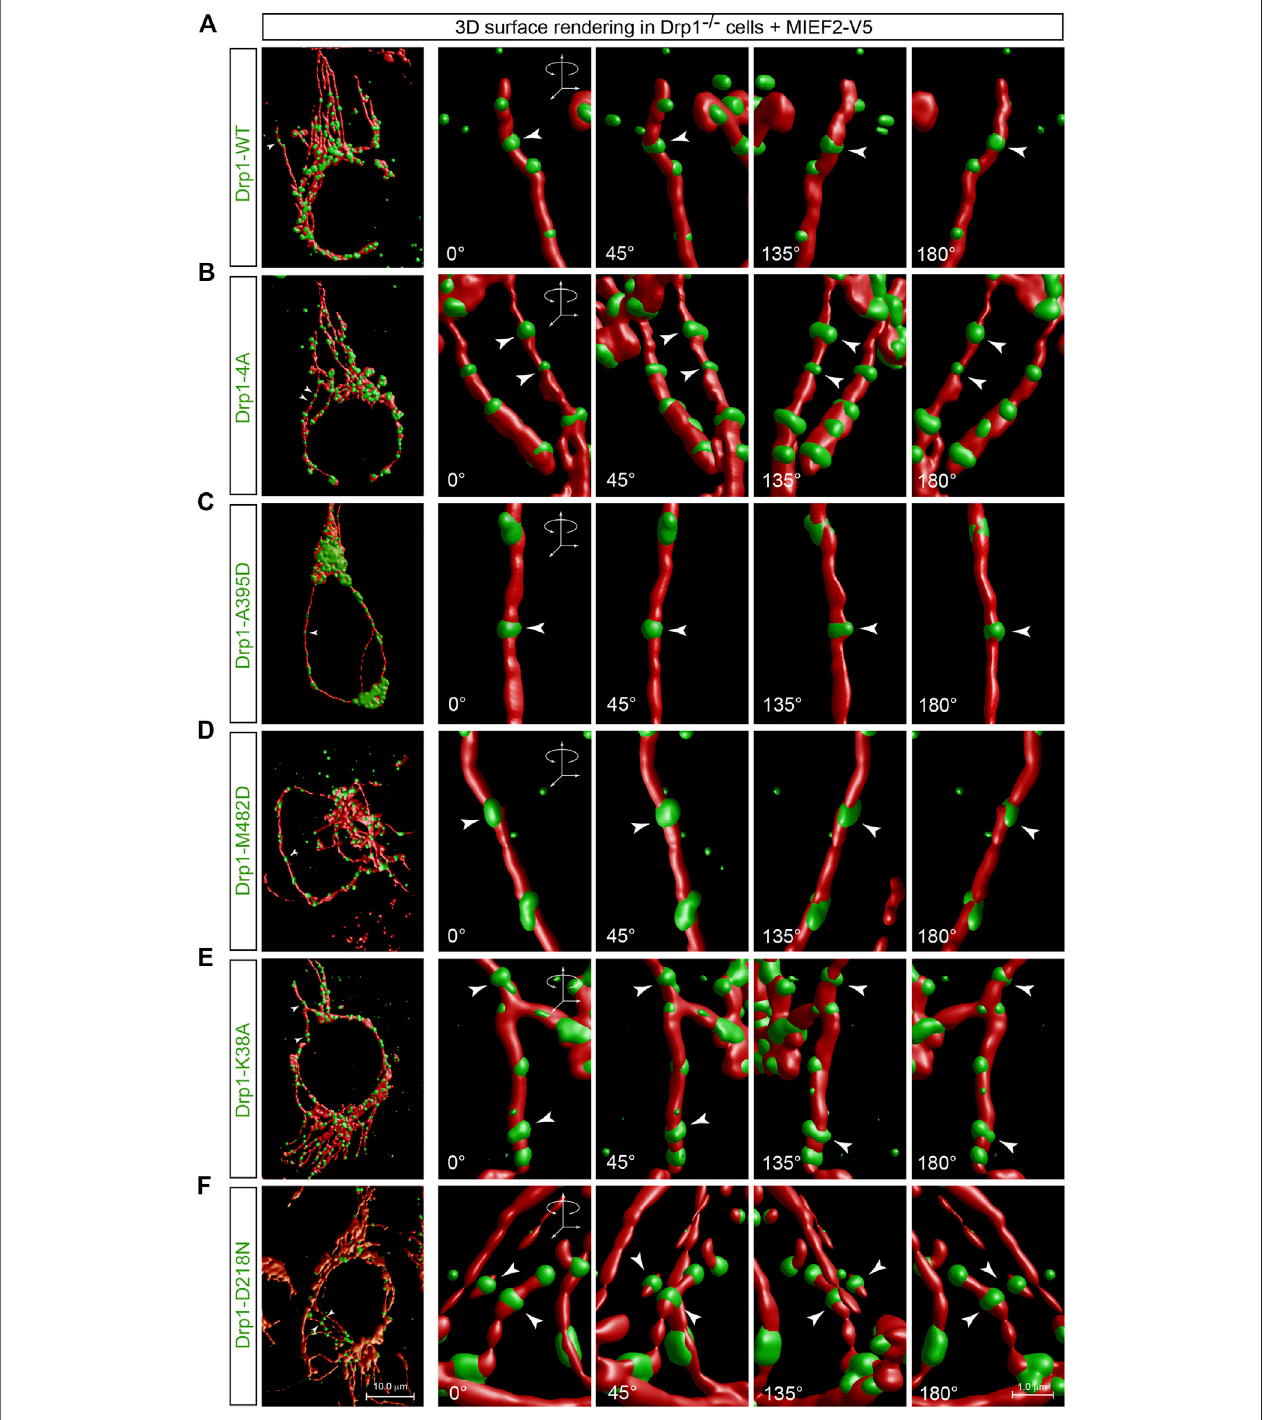
FIGURE 7 | MIEFs induce assembly of Drp1 into ring-like structures wrapping around mitochondria regardless of whether Drp1 is active or not. (A – F) 3D surface renderingreconstructionofDrp1punctatestructuresonmitochondriainDrp1 − / − 293Tcellsco-transfectedwithMIEF2-V5 andDrp1-WT (A) ,Drp1-4A (B) ,Drp1-A395D (C) ,Drp1-M482D (D) ,Drp1-K38A (E) orDrp1-D218N (F) .At16 hpost-transfection,cellswerestainedwithMitoTracker(red)andanti-Drp1(green)antibody(theoriginal confocal images are shown in Figures 4 , 5 ). Arrows indicate Drp1 ring-like structures at a potential mitochondrial constriction site.